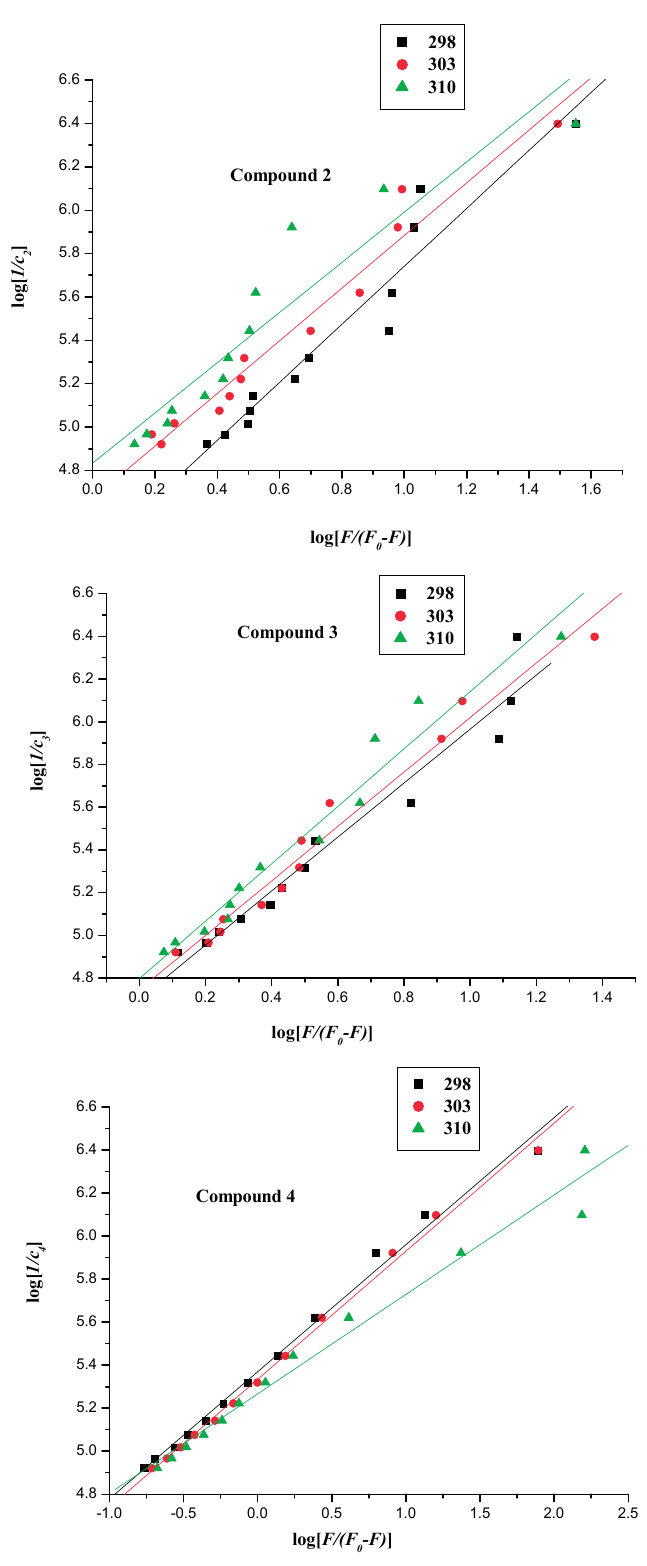
Figure 8. Linear plot of log [1/ c comp. ] vs. log [ F /( F 0 − F )] of the interaction between compounds 1 – 4 and BSA at different